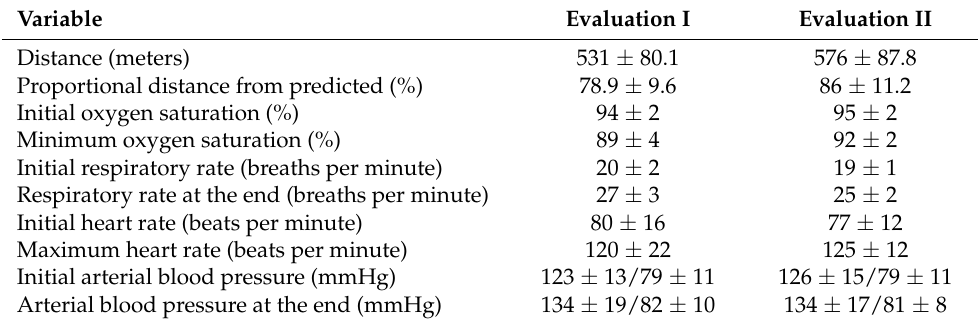
Table 5. Mean and standard deviation of the mean of the cardiorespiratory measurements during the 6 Minute Walk Test in 43 patients at the first evaluation and 40 patients at the second evaluation. Variable Evaluation I Evaluation